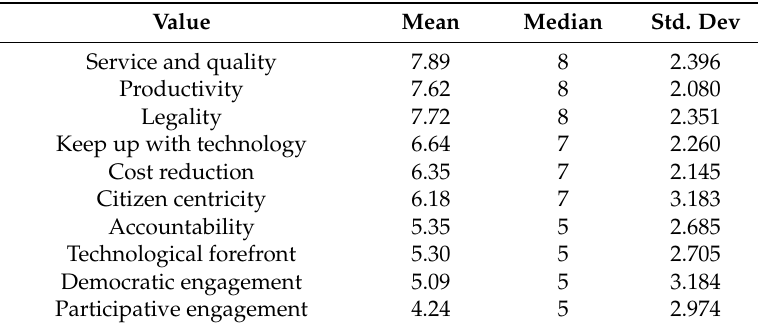
Table 7. Descriptive statistics, national agencies.